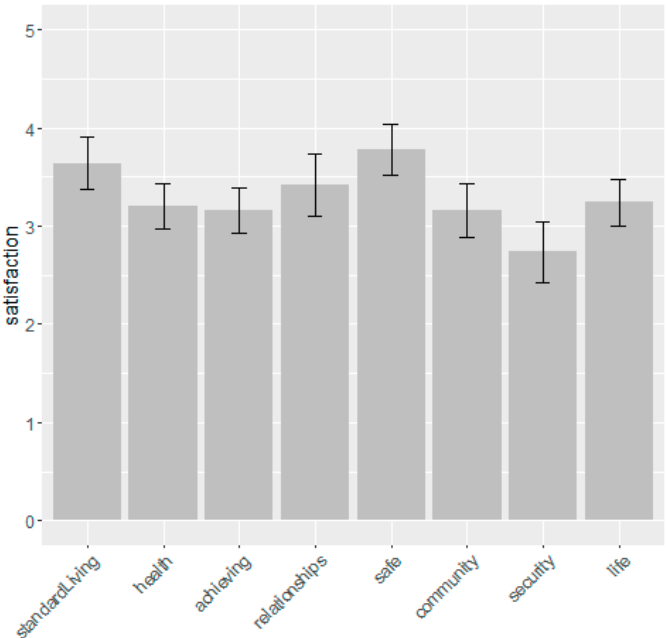
Figure 9. Respondents individual Personal Wellbeing Index scores. 95% confidence intervals are shown.